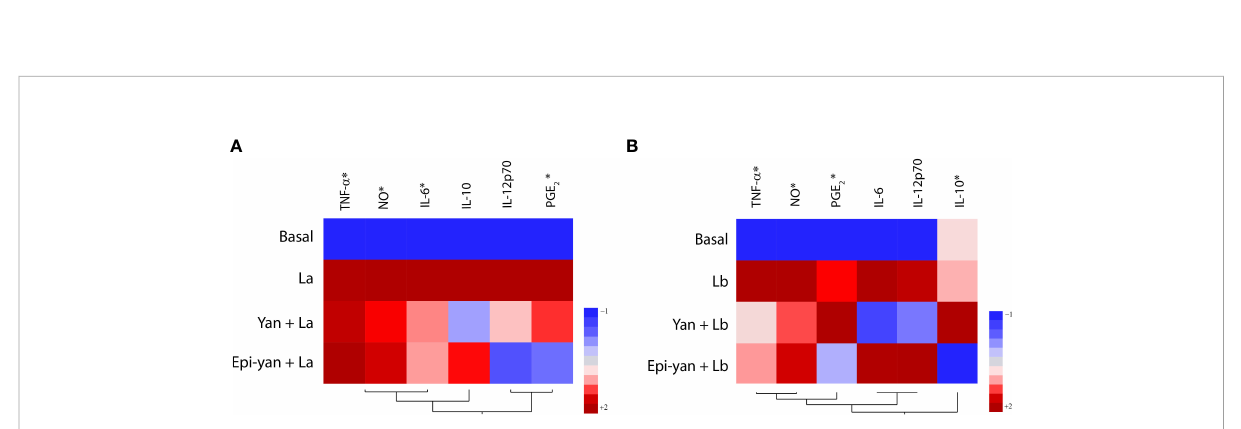
FIGURE 6 In fl ammatory pro fi le of yangambin- and epi-yangambin-treated macrophages infected with either L. amazonensis or L. braziliensis . Hierarchical clustering analysis (Ward ’ s method) was used to assess whether cytokine production could differentiate between (A) Leishmania amazonensis or (B) Leishmania braziliensis , infection, in cells treated or not with yangambin or epi-yangambin, as described in Materials and Methods. La, Leishmania amazonensis ; Lb, Leishmania braziliensis ; Yan, yangambin; Epi-yan,